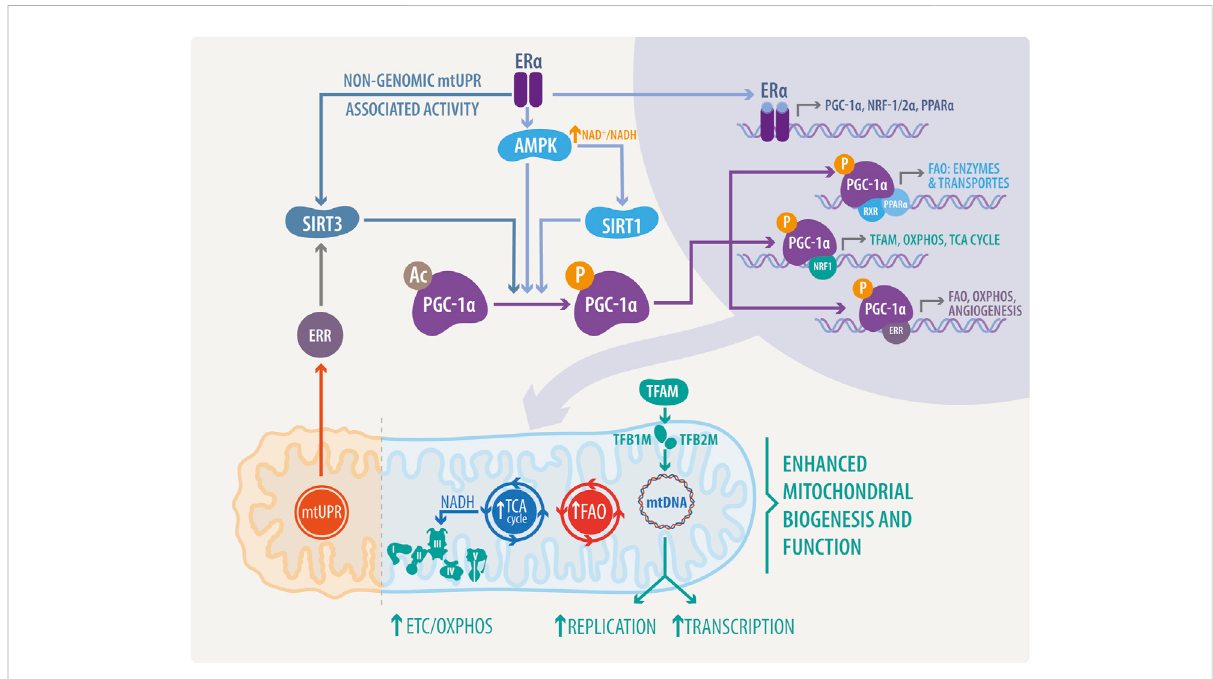
FIGURE 3 Integrated mechanisms of estrogenic and ERs activity in nucleus-mitochondria communication. PGC-1 α activity, a master regulator of mitochondrial biogenesis and activity, can be regulated by SIRT1-mediated deacetylation, mtUPR associated SIRT3-mediated deacetylation via Er α / ERR, or directly through phosphorylation by adenosin monophosphate activated-kinase (AMPK). Interestingly, ER α can bind to the catalytic subunit alpha of AMPK, regulating its activity in a non-genomic manner. PGC-1 α , NRF1/2 α , and PPAR α transcription is mediated by ERs in the nucleus. Once translated to functional proteins, these transcription factors directly regulate mitochondria, stimulating the expression of proteins, enzymes and transporters involved in mitochondrial replication and transcription, such as TFAM, OXPHOS, ETC, TCA cycle, and